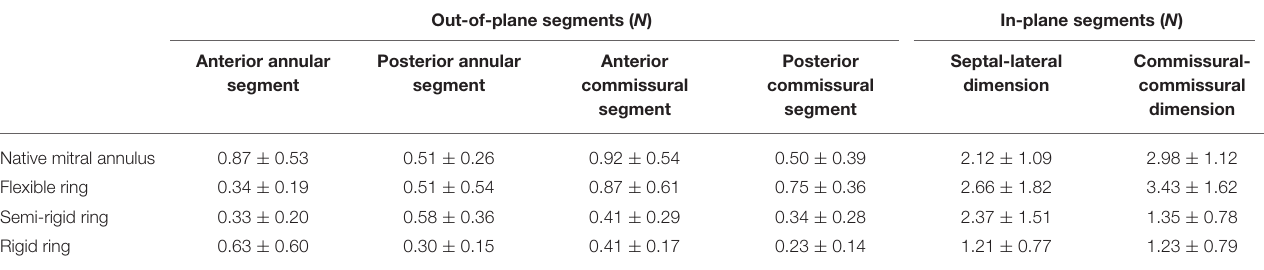
TABLE 5 | Overview of forces in the mitral annulus in accordance with ring type.